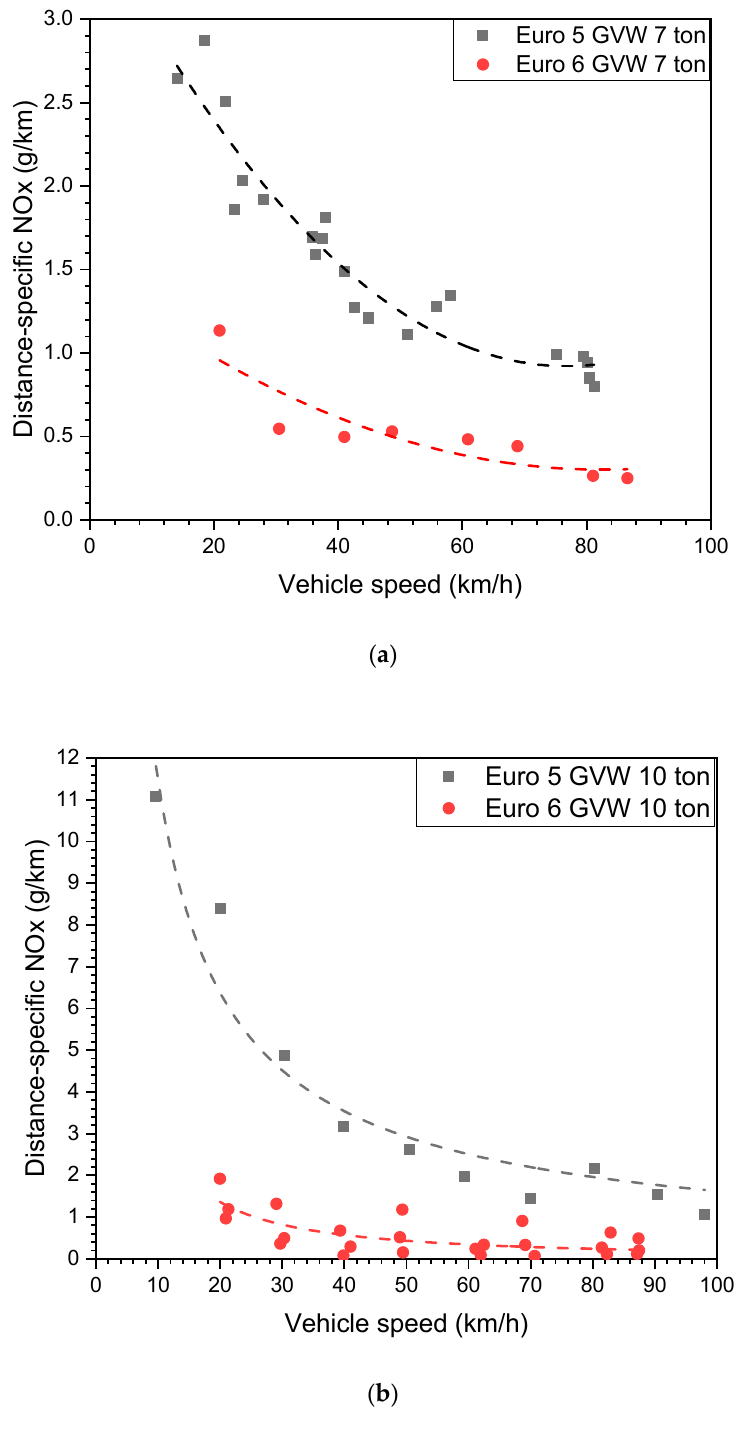
Figure 5. On-road NOx emissions from Euro 5 and Euro 6 HDVs relative to the average vehicle speed. ( a ) 7 ton GVW truck; ( b ) 10 ton GVW truck.